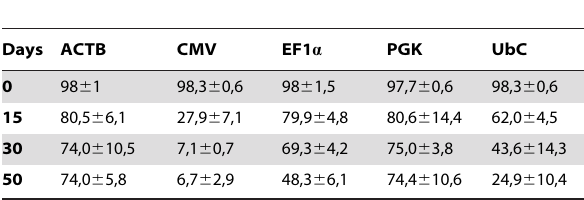
Table 1. % eGFP + cells of hESC line SA121 transduced with pTRIP-ACTB-, CMV-, EF1 a -, PGK or UbC-eGFP lentiviral